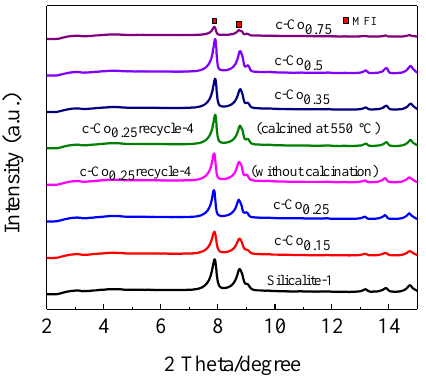
Figure 1. XRD patterns of the pristine silicalite-1 and c-Co x .